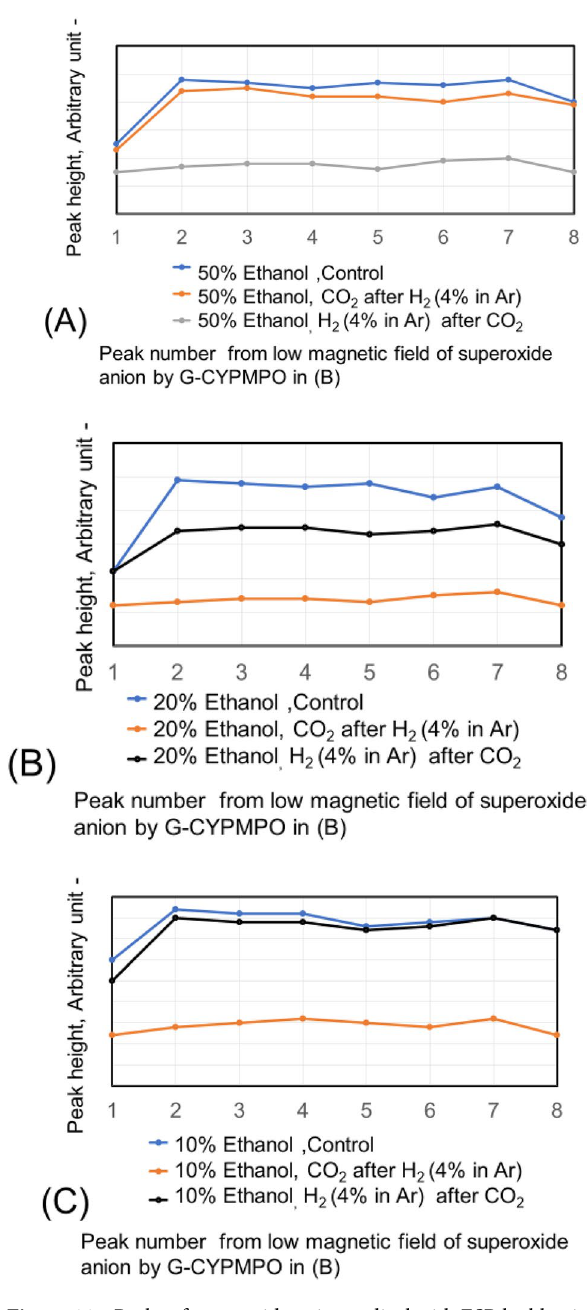
Figure 11. Peaks of superoxide anion radical with ESR by blowing CO 2 after H 2 (4% in Ar) gas nanobubble and H 2 (4% in Ar) after CO 2 gas nanobubble into 50, 20, and 10% ethanol aqueous